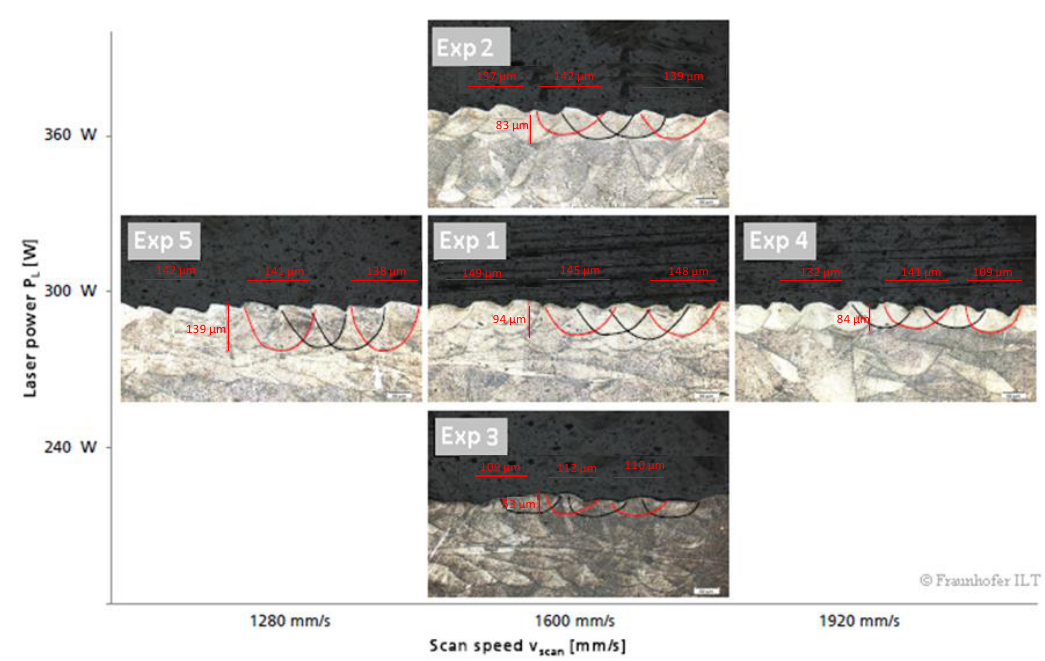
Figure 7. Macrographs of five selective laser melting (SLM) experiments with varying process parameters [13]. Table 1. SLM experiments using the alloy IN718. In the table we show the data of the five experiments, the energy per unit length delivered by the laser, and the upper bound (i.e., the maximum possible radius of molten material).